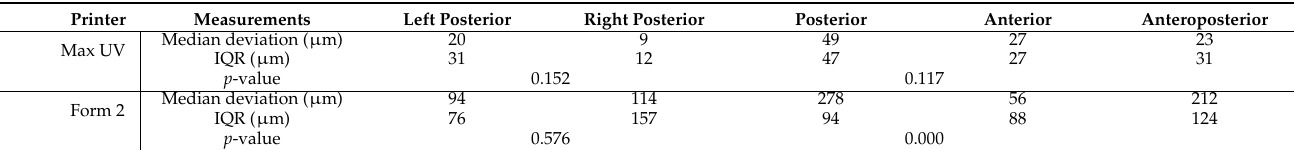
Table 3. Median deviation and interquartile range (IQR) of arch segments: left posterior; right posterior; posterior; anterior; anteroposterior of MAX UV and Form 2 3D printed models at T 1 .